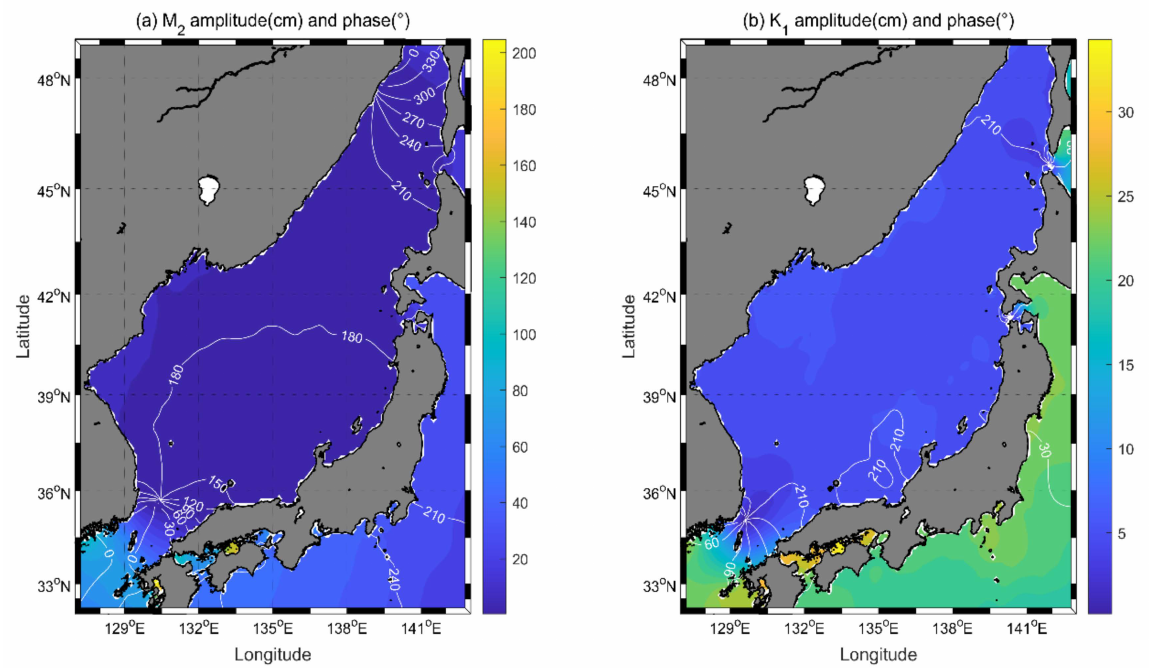
Figure 3. Cotidal charts for M 2 ( a ) and K 1 ( b ) tides in the East/Japan